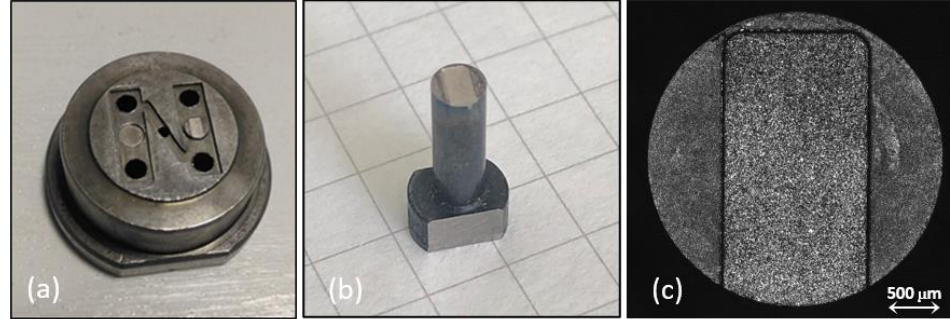
Figure 2. ( a ) Mold, ( b ) insert and ( c ) confocal image of the cavity.